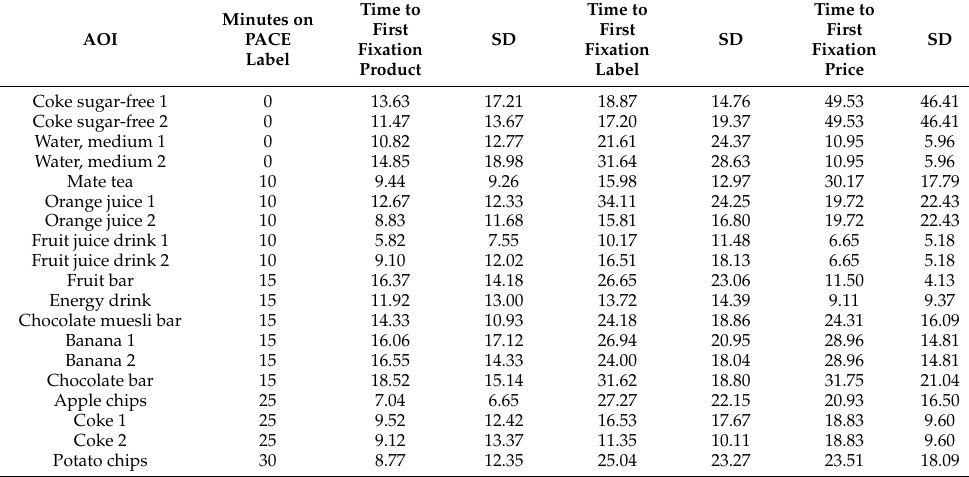
Table A1. Time to first fixation (TTF) (in seconds) and standard deviation (SD) of the products, the PACE label and the price in front of every product. Within the table, the data are sorted based on the minutes that were declared on the PACE label of the